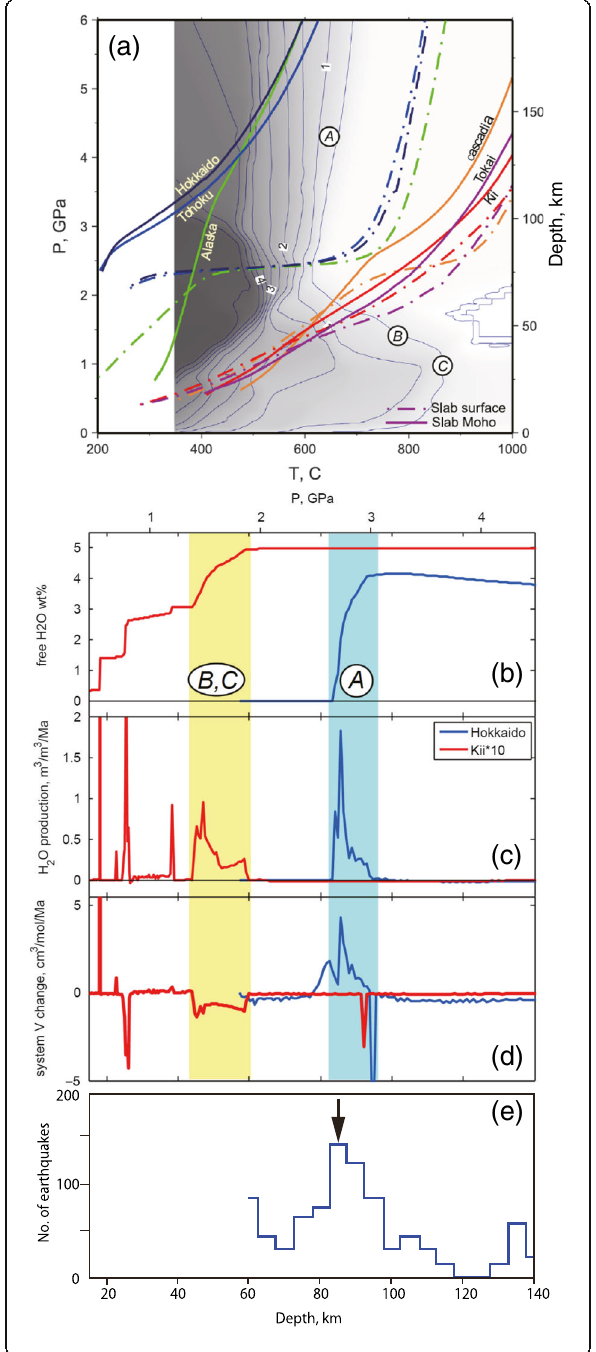
Fig. 11 P – T path, H 2 O production, system volume change, and frequency of earthquakes in the crust. a Pressure – temperature (P – T) paths of the subducting oceanic crust for six subduction zone segments plotted on a diagram of maximum H 2 O contents (Abers et al. 2013). P – T paths for the upper slab surface and slab Moho are shown as colored solid and dot dashed lines , respectively. Shading shows maximum H 2 O contents in wt% for a hydrated metabasalt of MORB bulk composition (Hacker, 2008). Major dehydration reactions are indicated by A (lawsonite breakdown), B (zoisite breakdown), and C (amphibole breakdown). b – d Evolution of pore fluid pressure and H 2 O content for cold and warm slabs (Abers et al. 2013). Hokkaido is indicated by blue lines as a representative cold slab and Kii by red lines as a representative warm slab. b Accumulated dehydration-derived H 2 O content in wt% as dehydration reactions progress. c Rate of H 2 O production, with Kii scaled by a factor of 10 relative to Hokkaido. d Total system (solid + H 2 O) volume. Shaded in light blue and yellow denote depth intervals of major dehydration for Hokkaido and Kii, respectively. A , B , and C denote specific reactions shown in Fig. 11a. e Frequency of upper-plane earthquakes beneath central Hokkaido (Fig. 7d) as a function of depth (Kita et al.